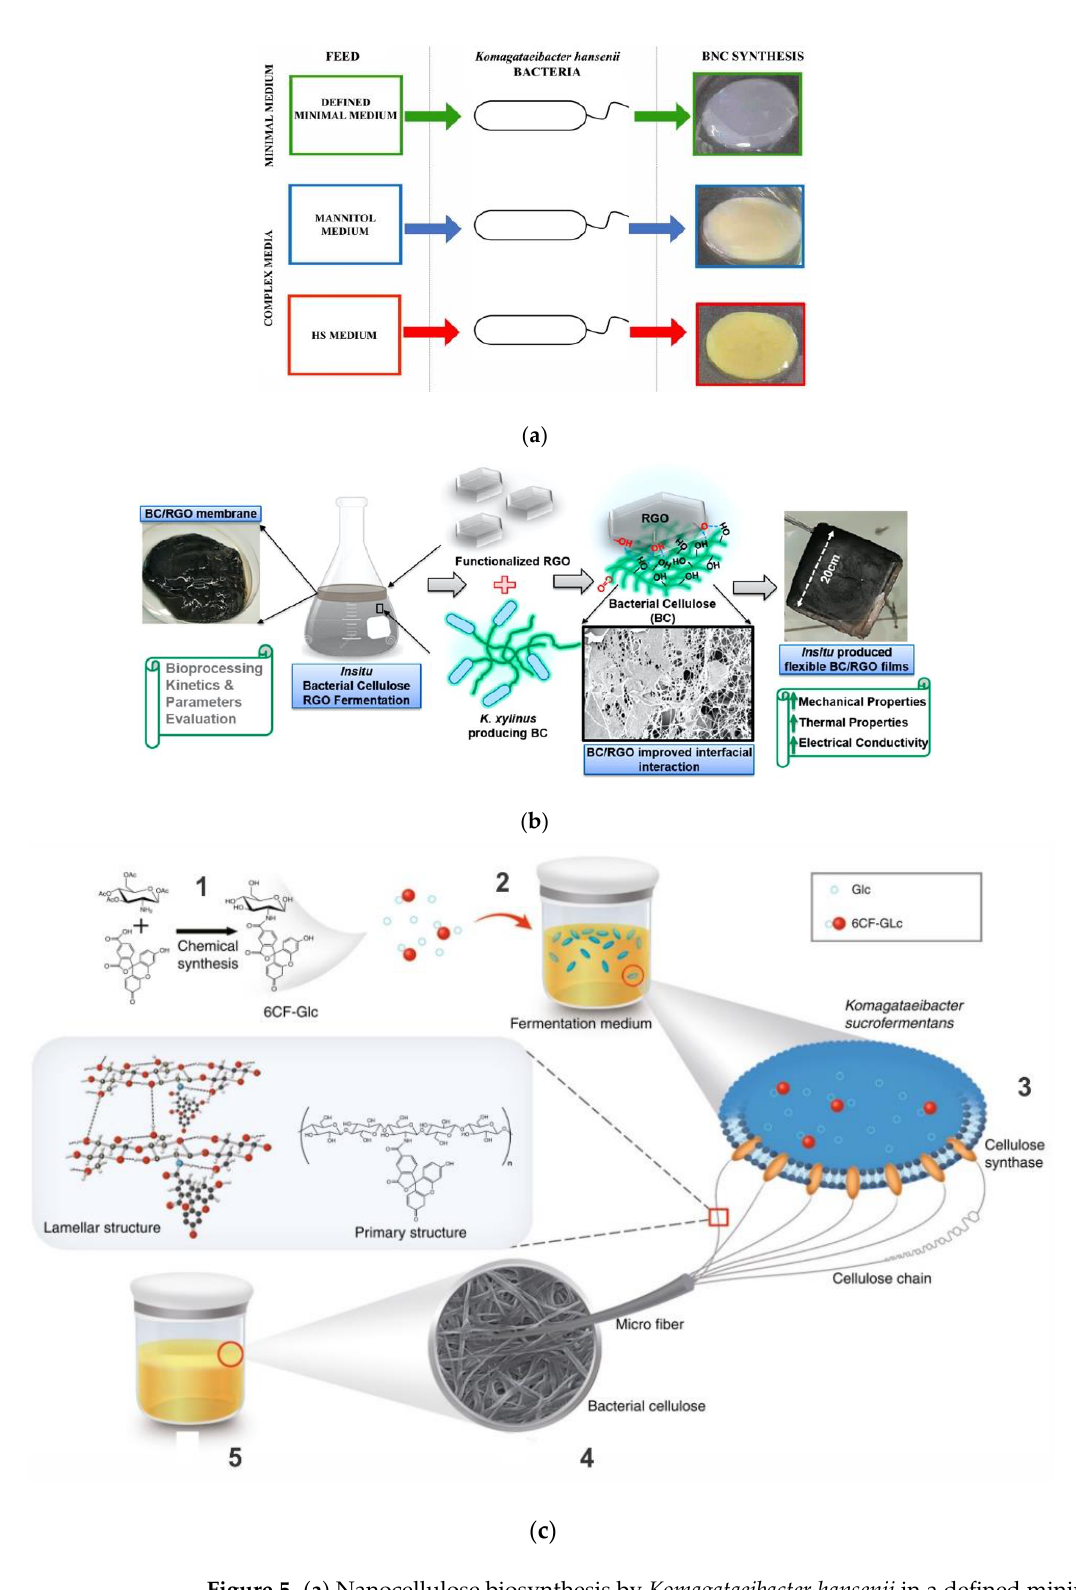
Figure 5. ( a ) Nanocellulose biosynthesis by Komagataeibacter hansenii in a defined minimal culture medium. Membranes with increased optical properties are visible in the figure. Reproduced